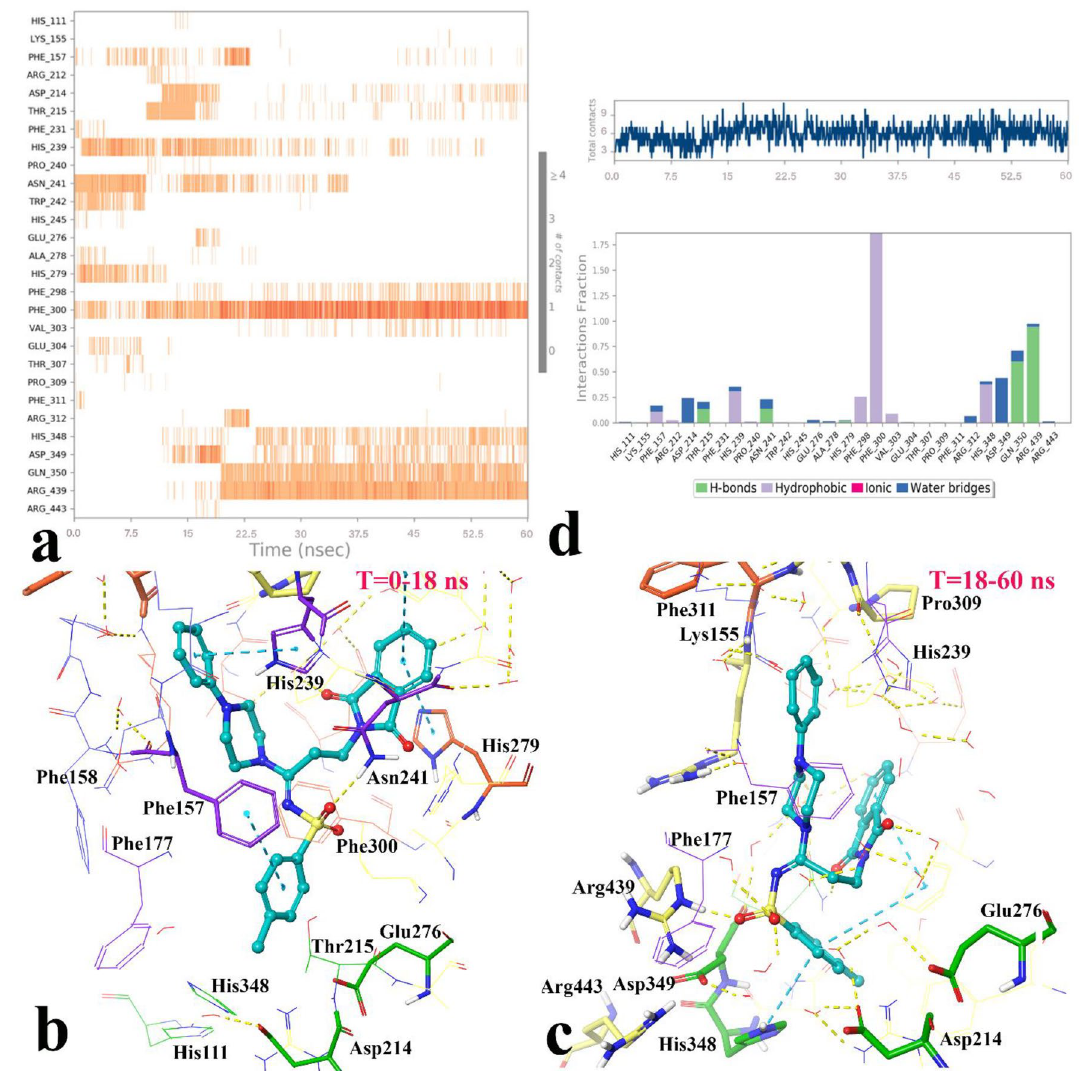
Figure 10. The timeline representation of the interactions shows the residues interact with compound 4m in each trajectory frame (more than one specific contact with the ligand is represented by a darker shade of orange) ( a ). The 3D representation of α-glucosidase in bound-state with compound 4m in two different orientations related to 0–15 ns ( b ) and 15 to the rest of simulation time ( c ). The quantity of contacts and the simulation interactions diagram panel in which the stacked bar charts are normalized over the course of the trajectory: some protein residues may make multiple contacts with the ligand ( d ) (Desmond